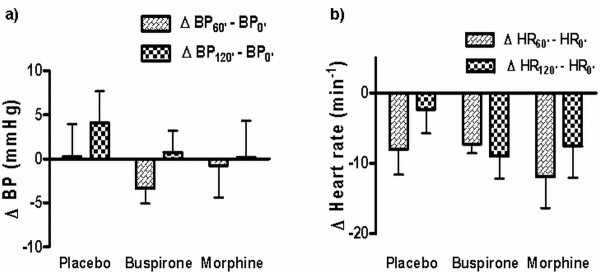
Hemodynamic parameters. Hemodynamic parameters 60 and 120 minutes following buspirone and morphine administration: The values are expressed as change in the blood pressure or heart rate from the pre-treatment value. a) Systolic blood pressure change, b) Heart rate change. Blood pressure and heart rate changes following the two drugs were not significantly different than with placebo (p < 0.05). BP0', BP60', BP120' = systolic blood pressure at the time of drug administration (0) and 60 and 120 minutes after drug administration. HR0', HR60', HR120' = heart rate at the time of drug administration (0) and 60 and 120 minutes after drug administration.